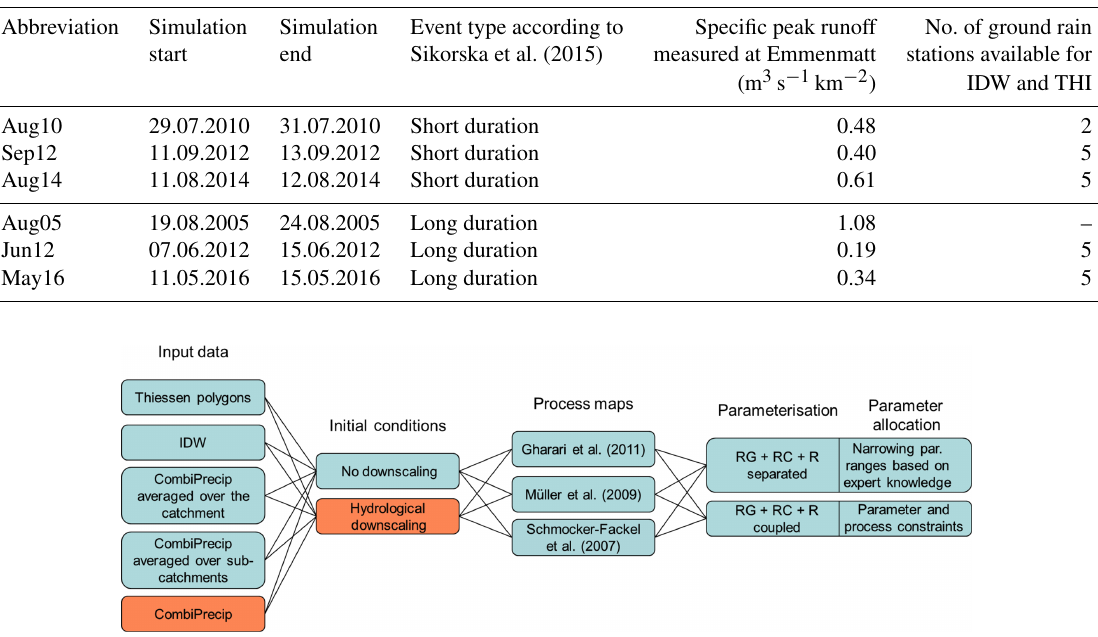
Table 4. Start and end of the simulated events. IDW = inverse distance weighting, THI = Thiessen polygons.